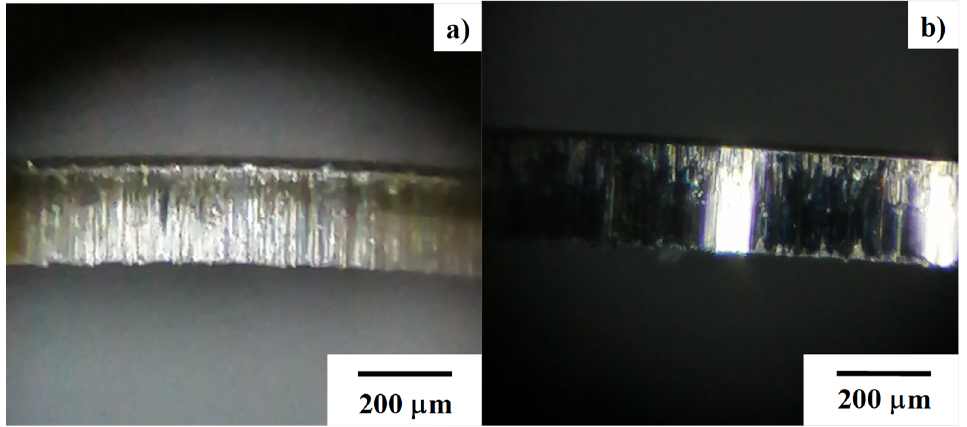
Figure 10. Comparison of hole surfaces pierced by the WC (Co) punch and by the trimmed diamond- coated WC (Co) punch. ( a ) Piercing by the bare WC (Co) punch and ( b ) piercing by the trimmed and diamond-coated WC (Co) punch.